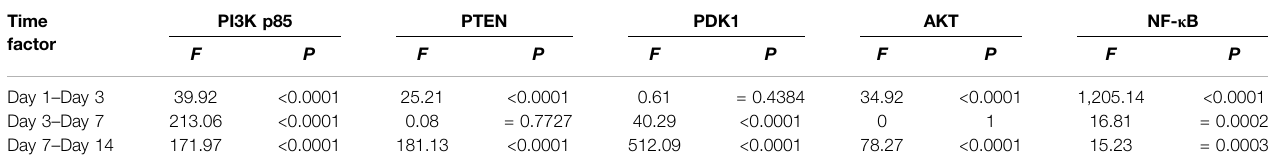
TABLE 7 | Simple effects of prolonged treatment time on PI3K-AKT1 signaling pathway ANOVA. Time factor